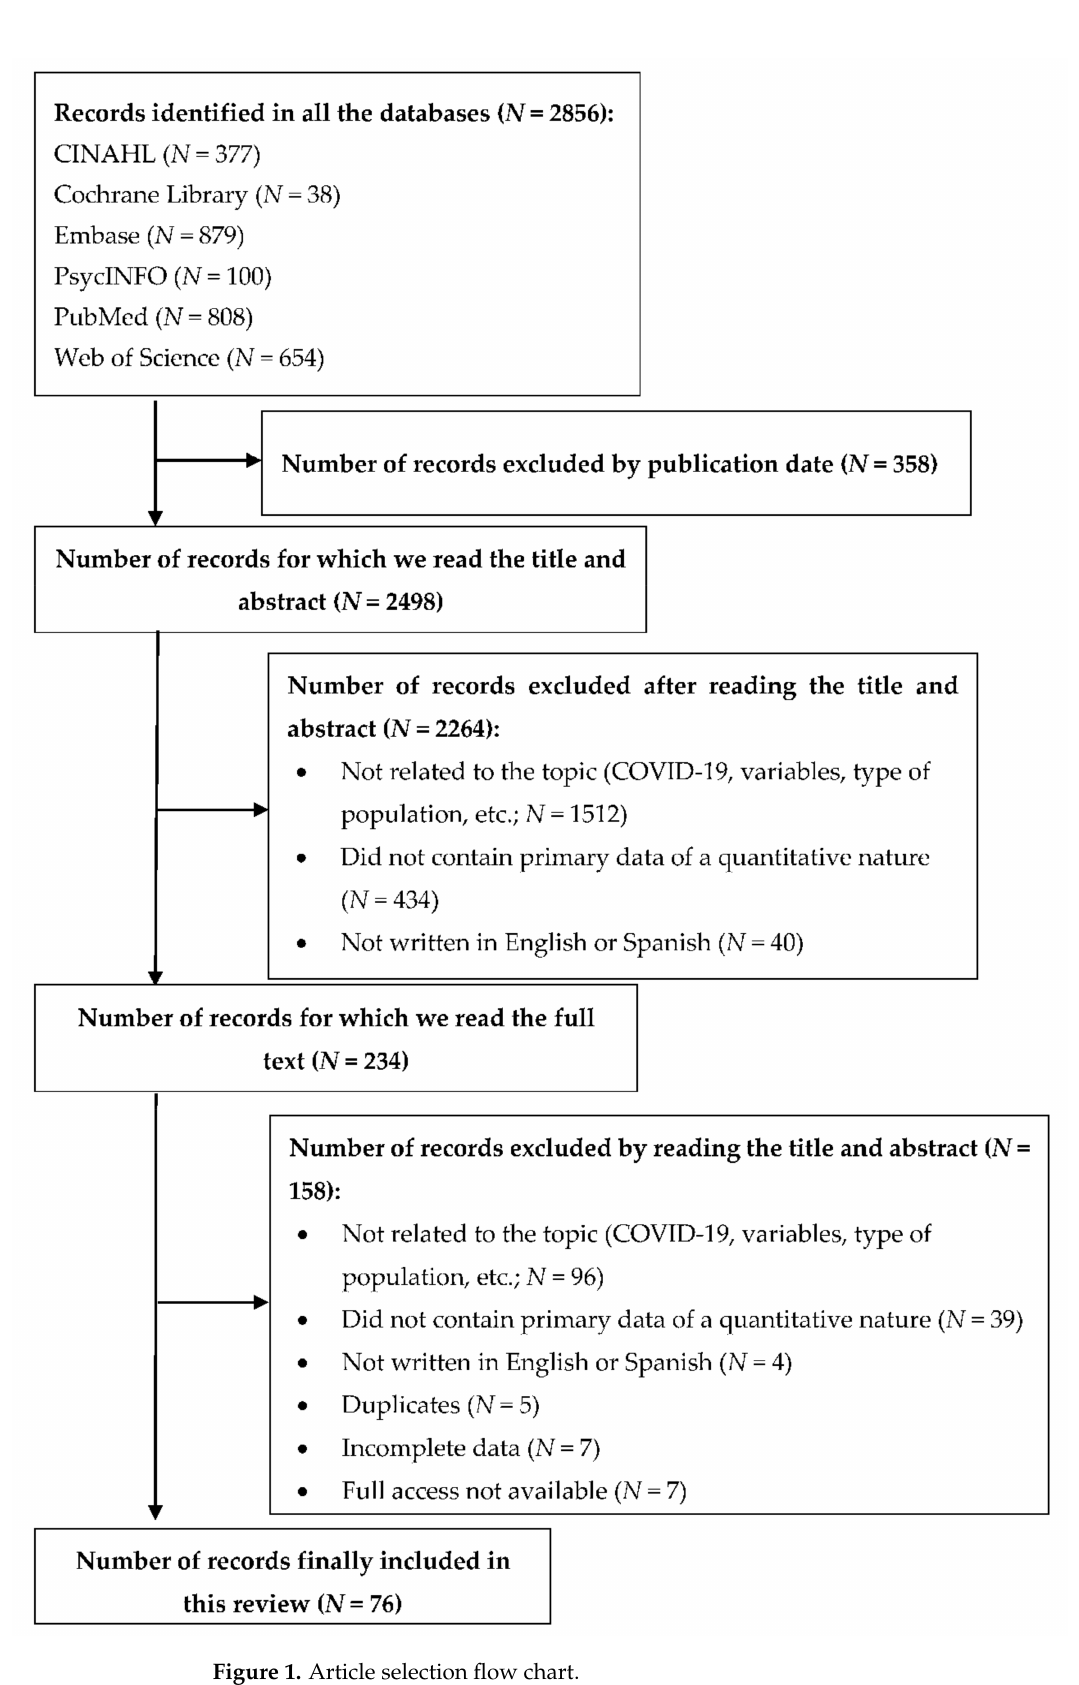
Figure 1. Article selection flow